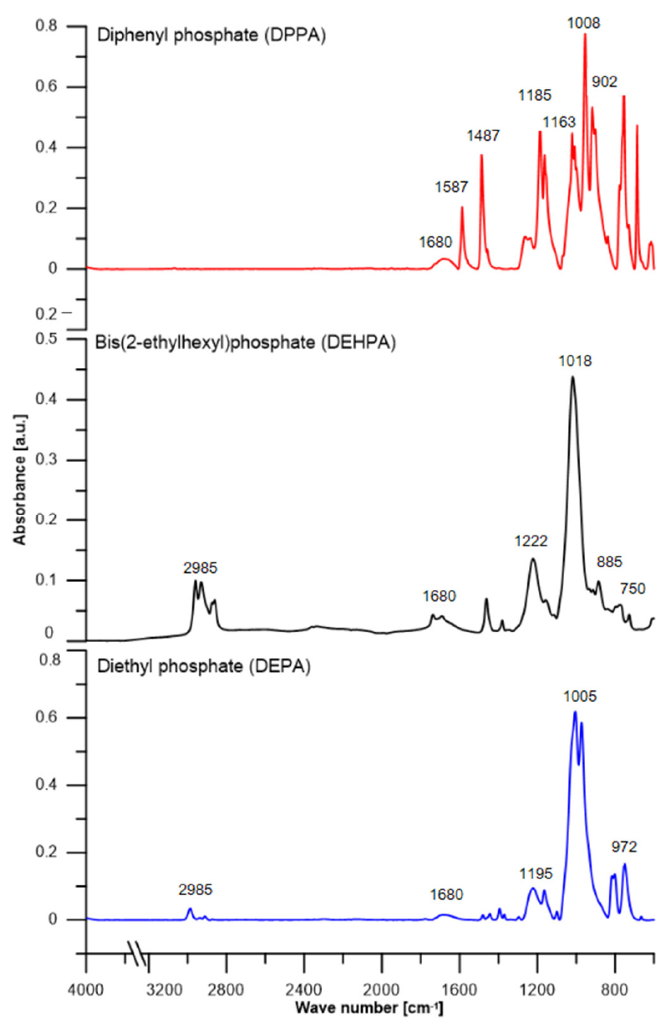
Figure 3. ATR/FT-IR spectra of phosphate samples. Table 3. Characteristic bands of ATR-FT/IR spectra of hybrids [cm −1 ].